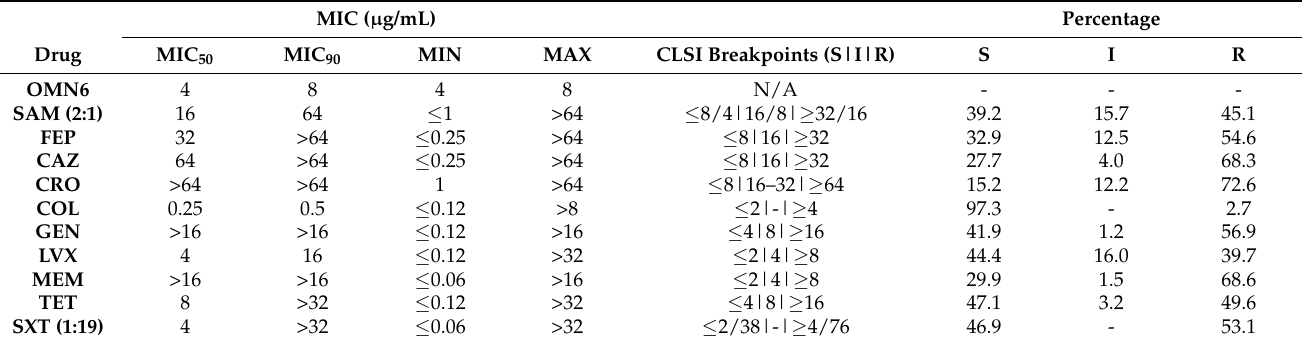
Table 1. Minimal Inhibitory Concentration (MIC) results against 401 A. baumannii isolates for OMN6 and comparator antibiotics. The bacteria were subjected to MIC tests by broth microdi- lution method following the principles outlined in Clinical and Laboratory Standards Institute (CLSI) guidelines. MIC 50 and MIC 90 represent the lowest MIC value required to inhibit the growth of 50% and 90% of the isolates tested, respectively. MIN and MAX represent the min- imum and maximum MIC values determined for each antibiotic tested with the clinical iso- lates, respectively. The resistance phenotype, determined by CLSI breakpoints and EUCAST interpretive criteria, is summarized as a percentage in the last column according to the fol-